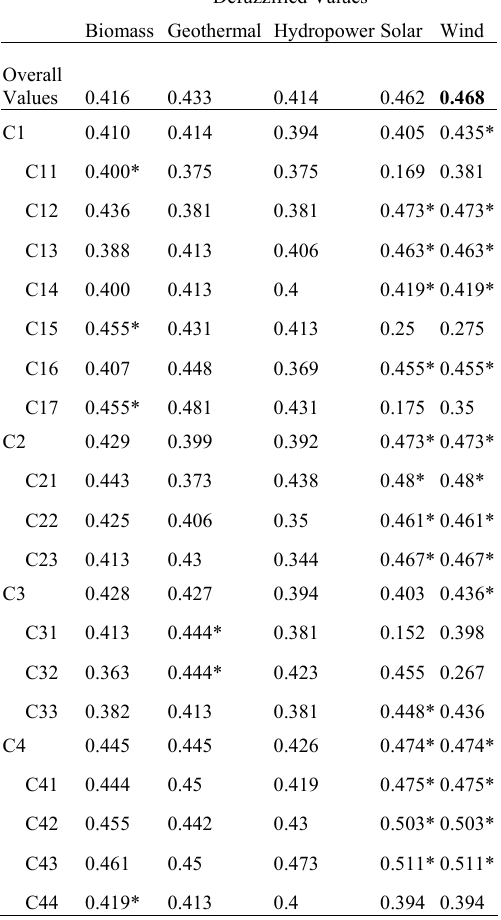
Table 6. The defuzzified